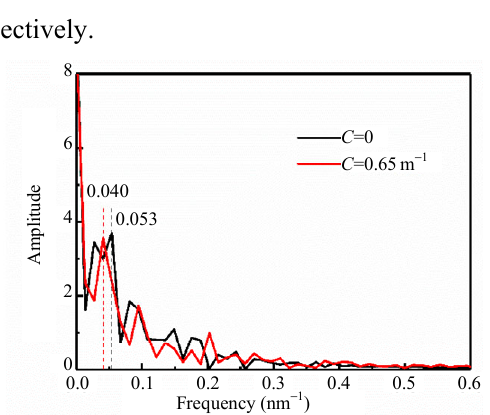
Fig . 8 Spatial frequency of the MZI before bending (0 m − 1 ) and after bending (0.65 m − 1 ).